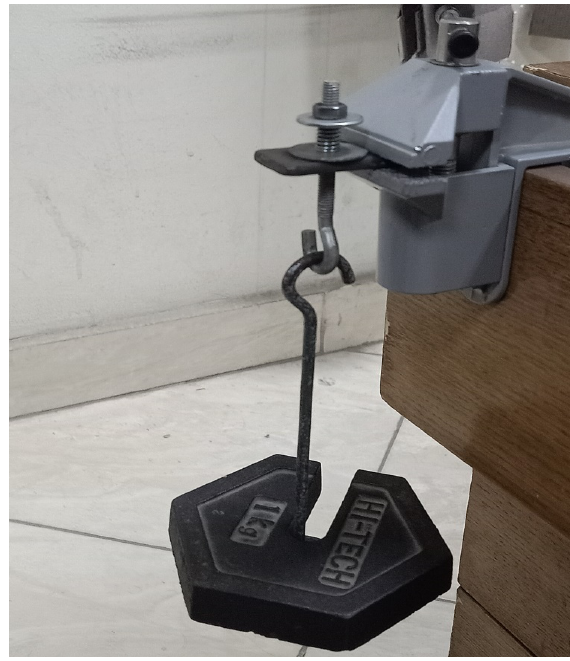
Figure 9. Experimental setup to measure the spring stiffness.